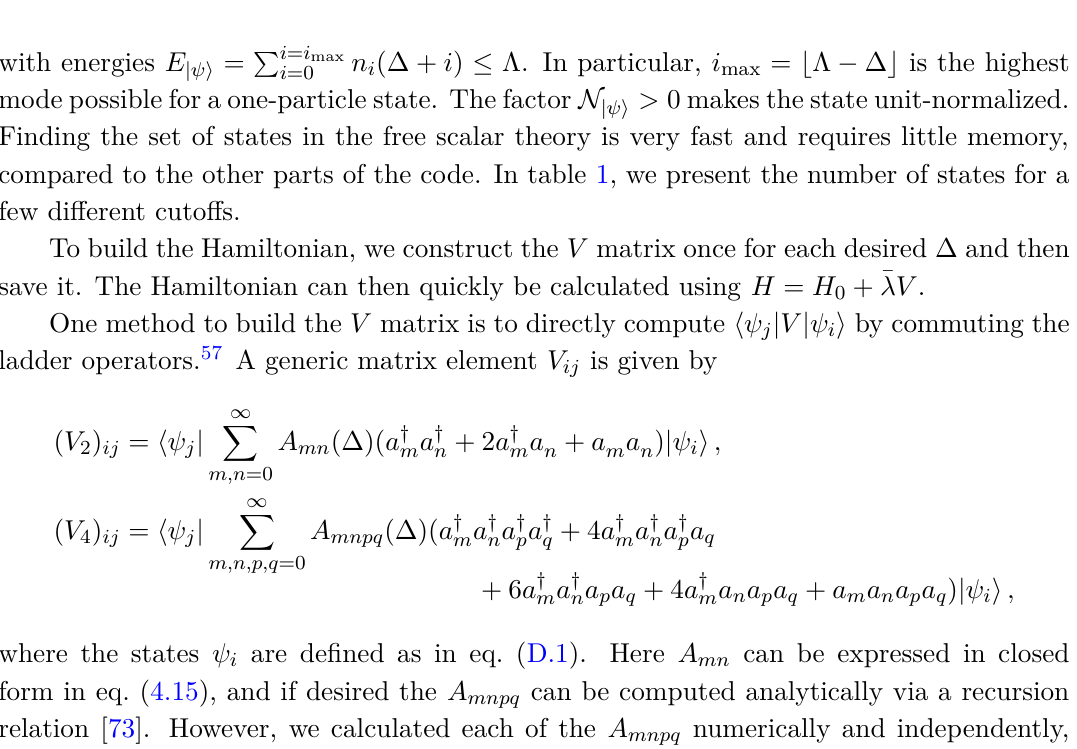
Table 1. Number of states at cutoff Λ for ∆ = 1 . 62 in scalar